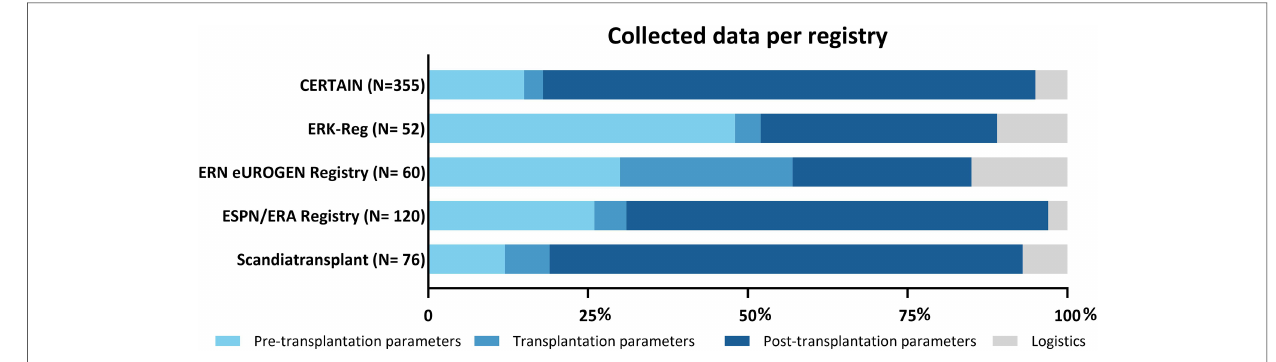
FIGURE 2 Distribution of collected datapoints by multinational European registries on paediatric kidney transplantation; N =number of parameters registered. CERTAIN, Cooperative European Paediatric Renal Transplant Initiative; ERKReg, European Rare Kidney Disease Registry; ERN, European Reference Network; ESPN/ERA, European Society for Paediatric Nephrology and European Renal